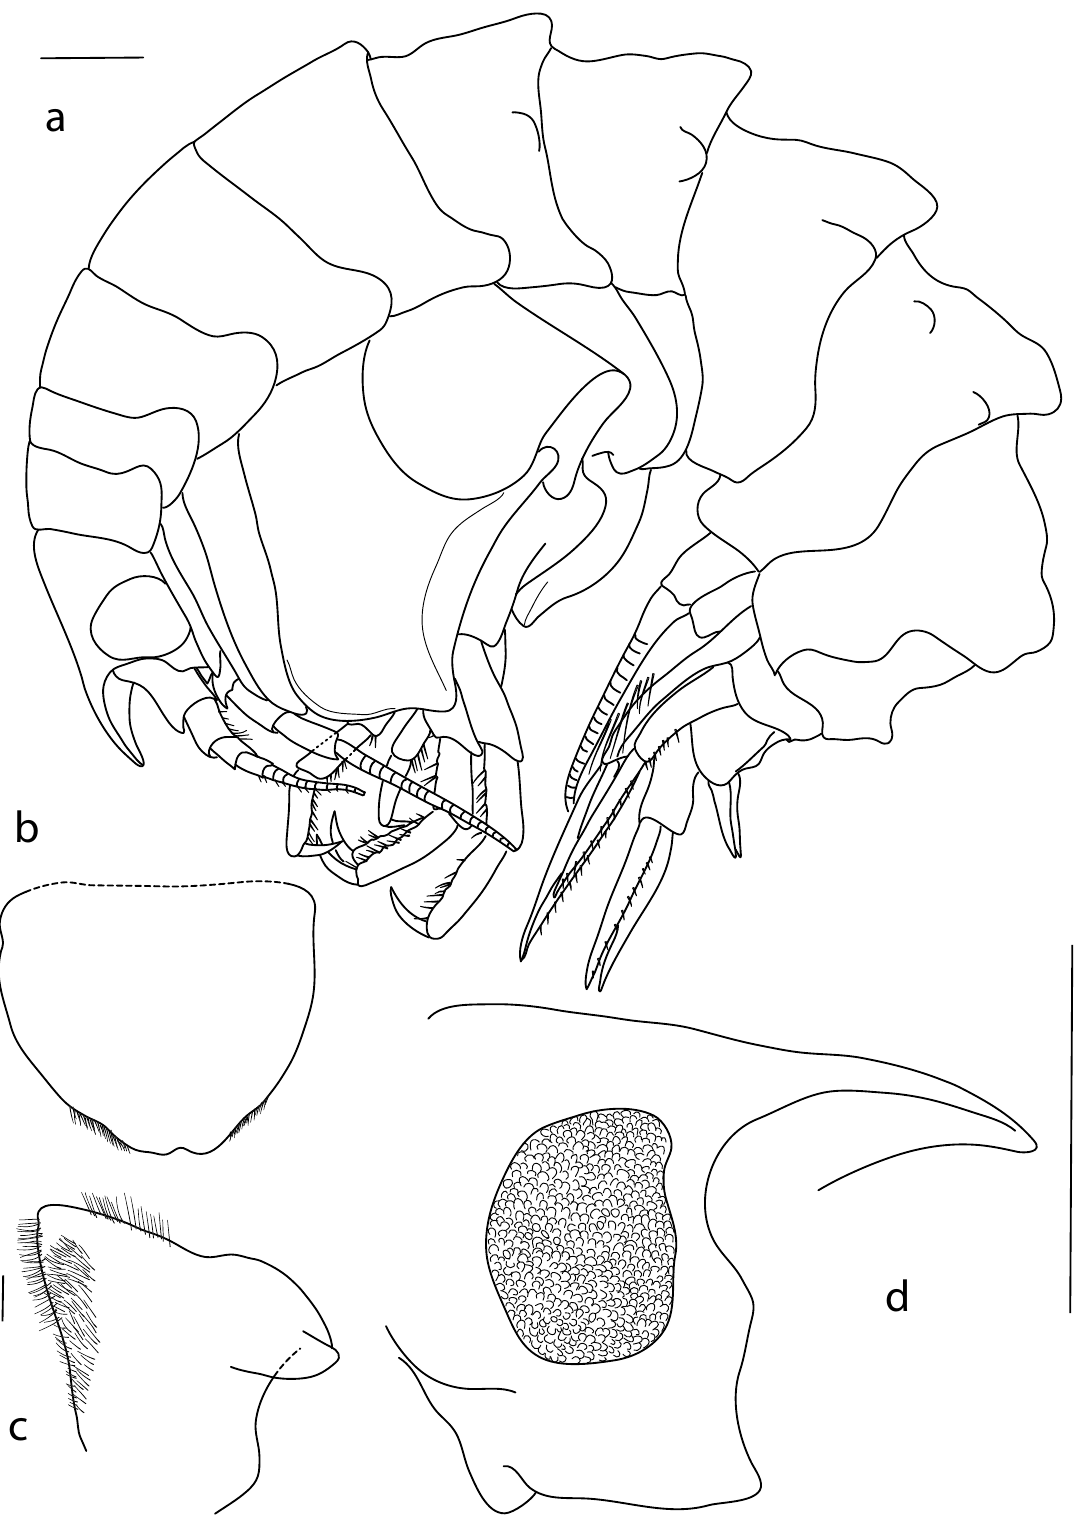
Fig. 12. Epimeria (Metepimeria) acanthurus (Schellenberg, 1931), ♀, 22 mm (ZMB 34099). a . Habitus, left body side. b . Upper lip. c . Lower lip, damaged. d . Right side of head. Scale bars: a, d = 1 mm; b–c = 100